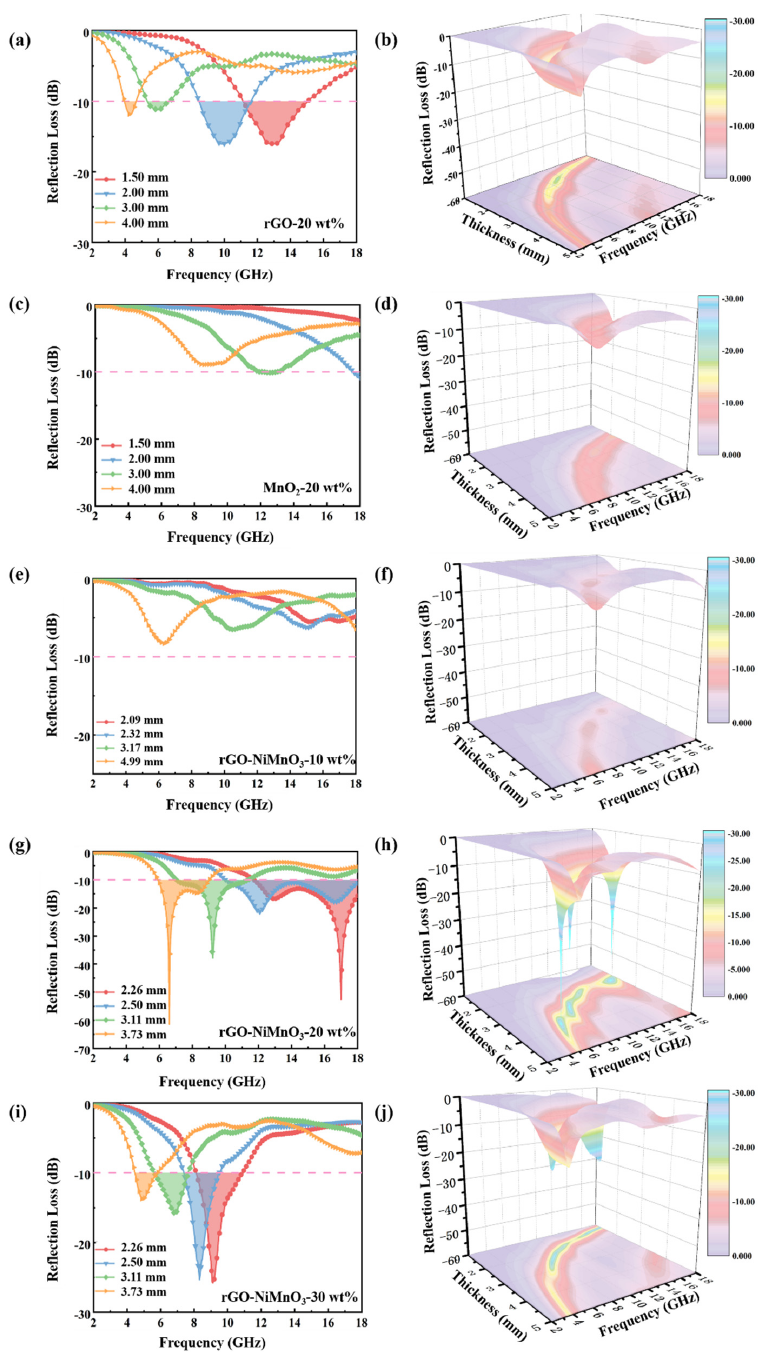
Figure 6. The 2D and 3D reflection loss diagram of rGO, MnO 2 and rGO-NiMnO 3 in 2–18 GHz. ( a , b ) rGO-20 wt%; ( c , d ) MnO 2 -20 wt%; ( e , f ) rGO-NiMnO 3 -10 wt%; ( g , h ) rGO-NiMnO 3 -20 wt%; ( i , j ) rGO-NiMnO 3 -30 wt%. The absorption strength reaches − 51.5 dB and − 62.4 dB, respectively. It is worth not- ing that at the thickness of 2.26 mm, the composite exhibits a high electromagnetic wave absorption strength, and the corresponding effective absorption bandwidth reaches 6.24